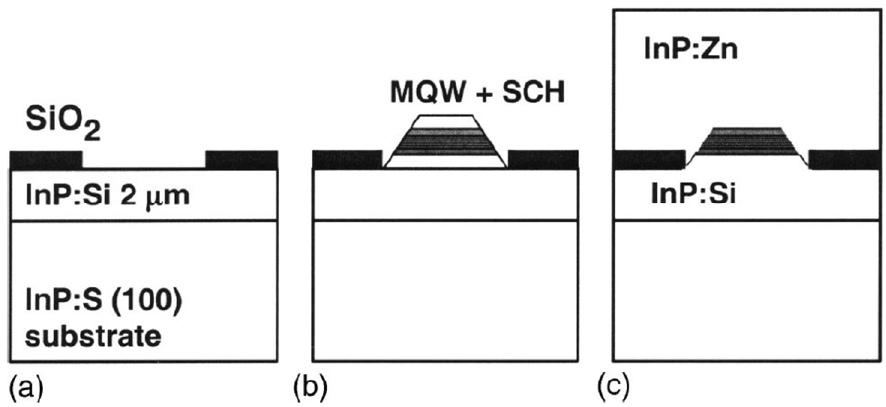
Figure 6. Process for a self-aligned BH laser. ( a ) n-type InP cladding layer and SiO 2 mask; ( b ) the active region and SCH under conditions wherein a {111} no-growth sidewall develops; ( c ) the upper p-type InP cladding layer. Reprinted with permission from ref. [41] © AIP Publishing. Copyright 2004 Applied Physics Letters.